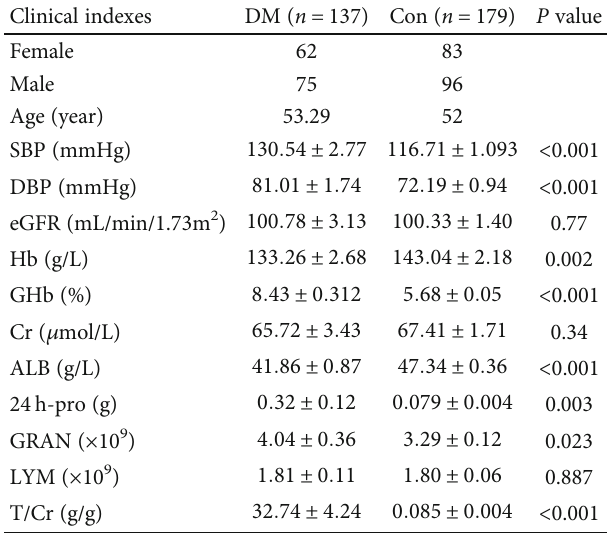
Table 1: The baseline data of participants. Clinical